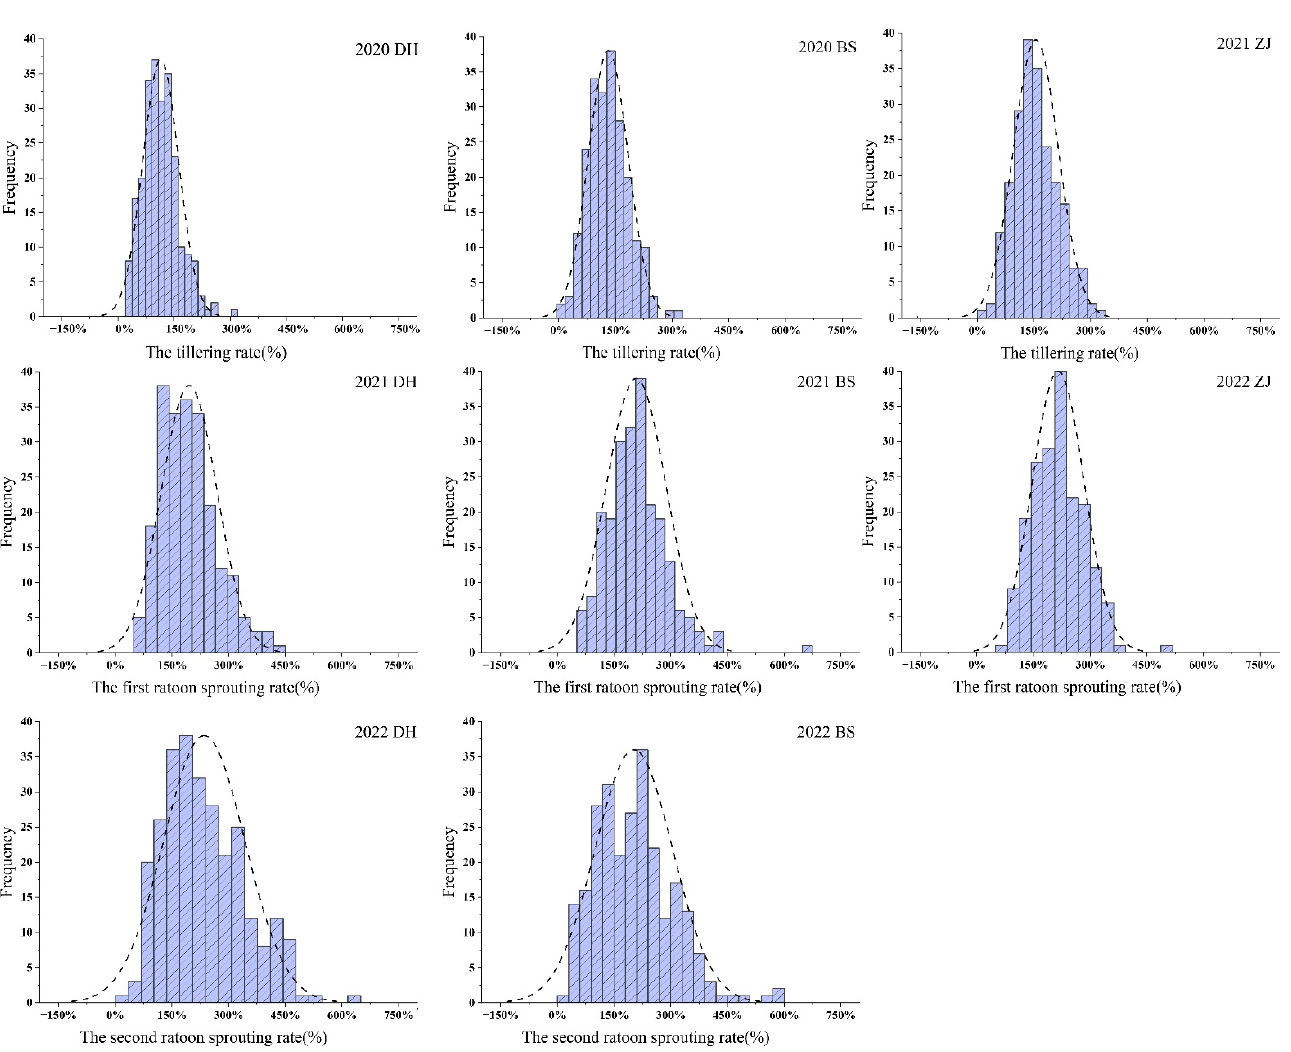
Figure 3. Frequency distribution of the tillering rate and the ratoon sprouting rate of the F 1 population in the plant cane and the ratoon cane, respectively.